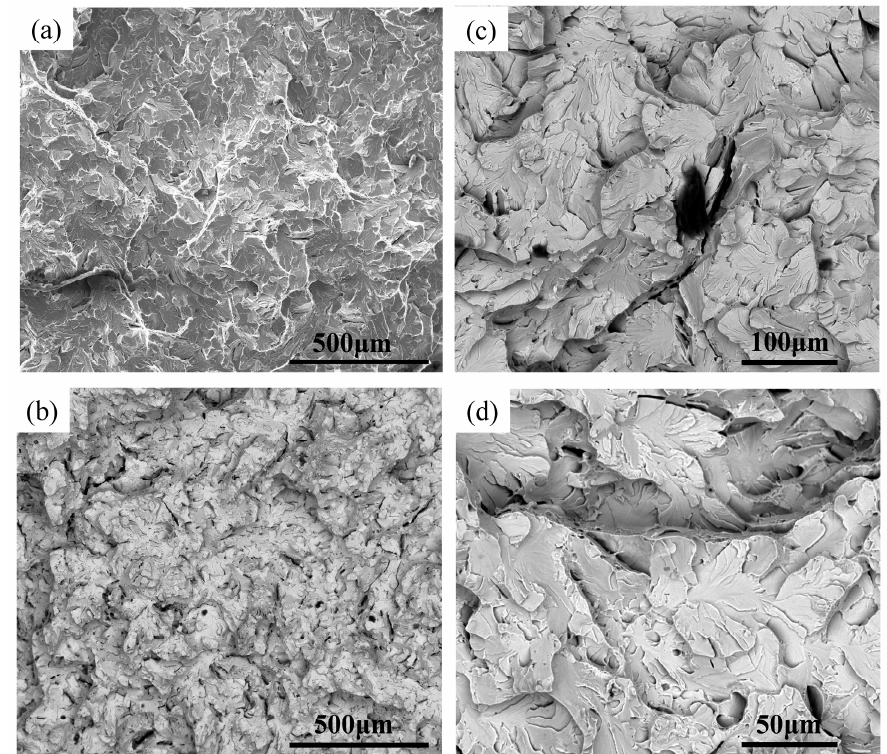
Figure 1. Fracture investigations of steel 1 ( a ) and steel 1-890 ( b ); higher magnification image of steel 1 ( c ) and steel 1-890 ( d ).